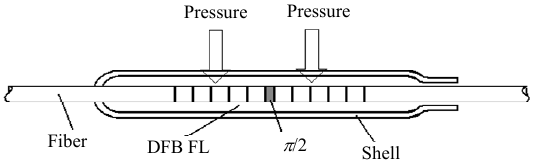
Fig. 3 Symmetrical structure of DFB fiber laser acoustic sensor.